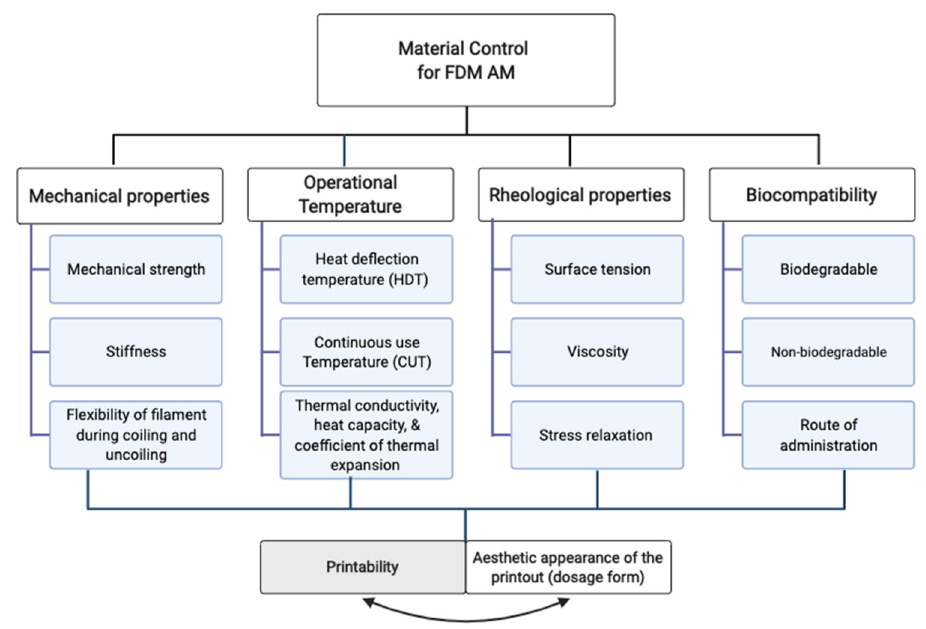
Figure 3. Schematic illustration of material control for FDM additive manufacturing.